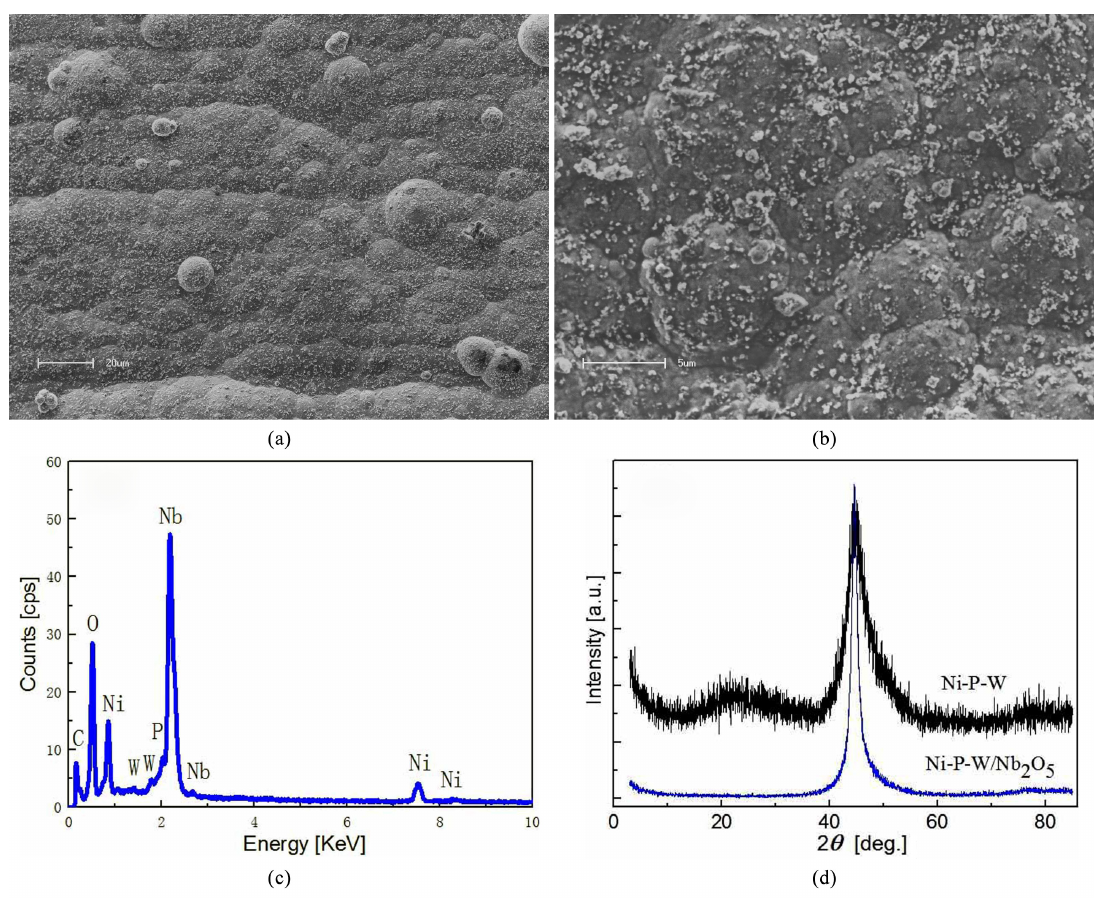
Figure 2. Morphology (a)×500, (b)×3000, EDX pattern (c) and XRD patterns of the coatings